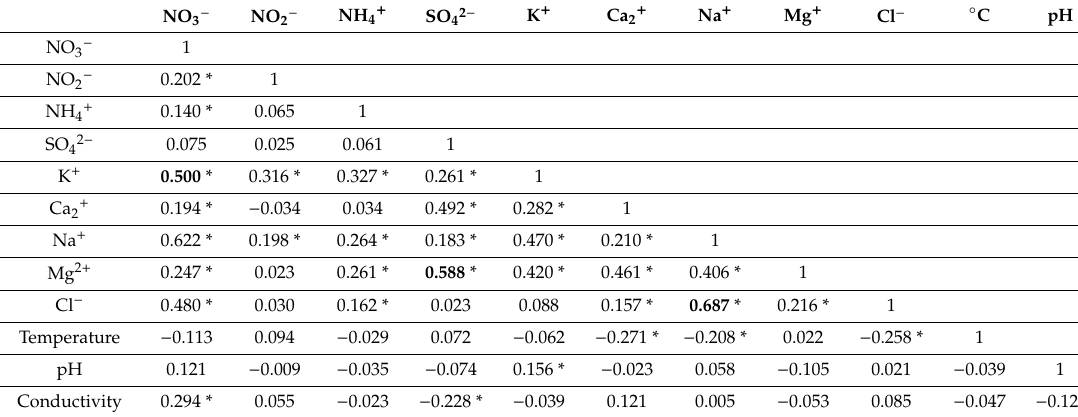
Table 3. Pairwise correlations among the variables, using data from all caves and all dates. Values in bold are greater than 0.5 and values marked with an asterisk are statistically significant ( p < 0.05). NO 3 − NO 2 − NH 4 + SO 42 − K + Ca 2 + Na + Mg + Cl − ◦